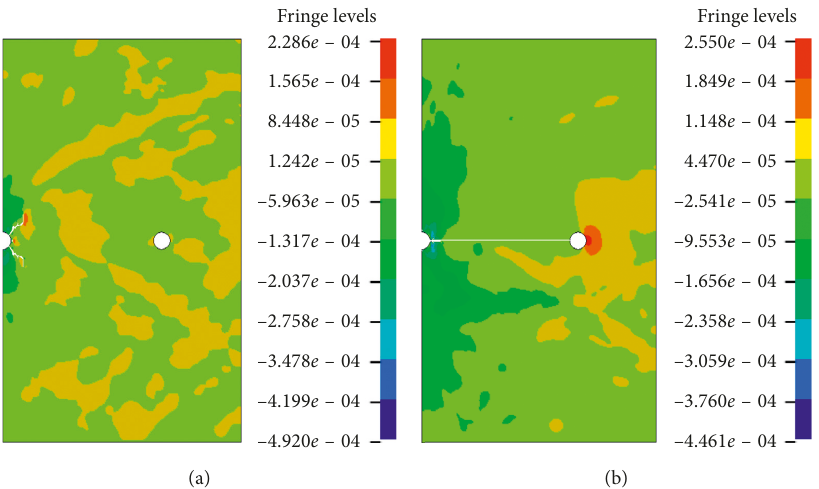
Figure 14: The tangential tensile stress nephogram at the time of 536 μ s (unit: 10 11 pa). (a) The PBH is a round hole. (b) The PBH is a notch hole.